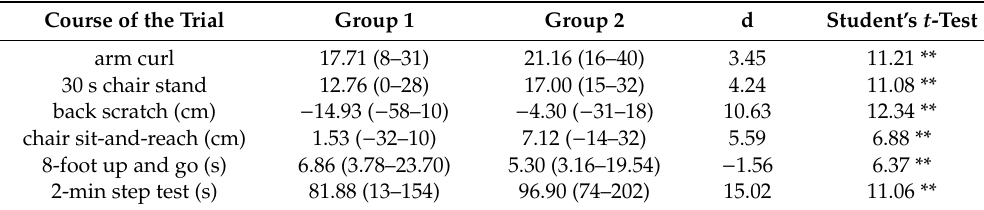
Table 4. Di ff erences in the level of functional fitness among the older male adults.